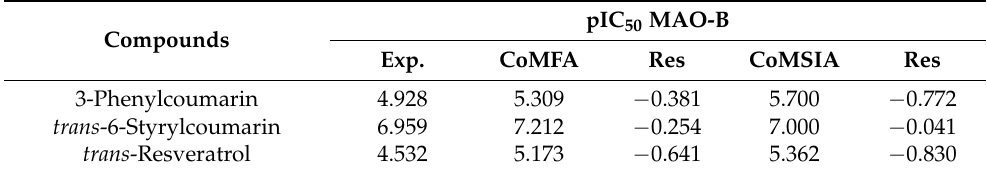
Table 3. Experimental and calculated inhibitory activities of 3-phenylcoumarin, trans -6- styrylcoumarin and trans -resveratrol on MAO-B. Compounds